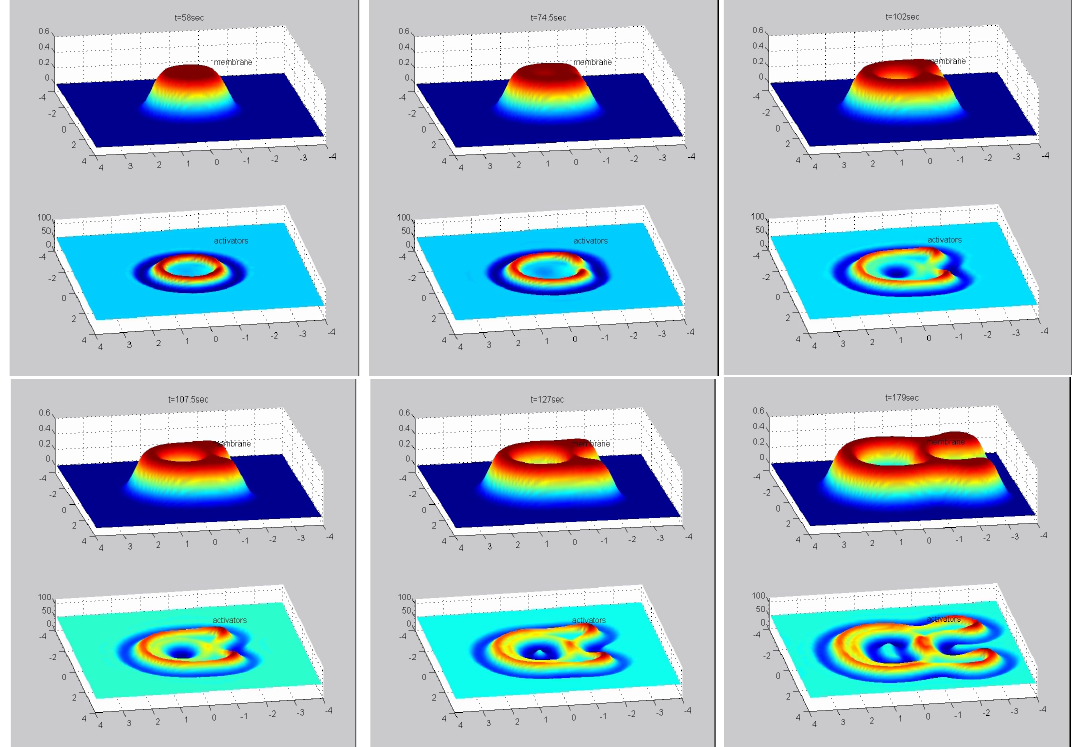
Figure 4. Numerical integration of a ring expanding over a membrane that contains a cylindrical ridge along the x -axis. From top-left to bottom-right, each panel shows the system at increasing time, with the membrane shape and activator density in the top and bottom parts, respectively. We used the same parameter values as in Figure